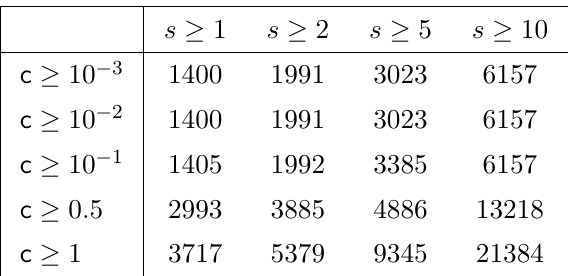
Table 1 . Smallest values for N flux for given bounds on the Kähler-cone parameter c and the dilaton s